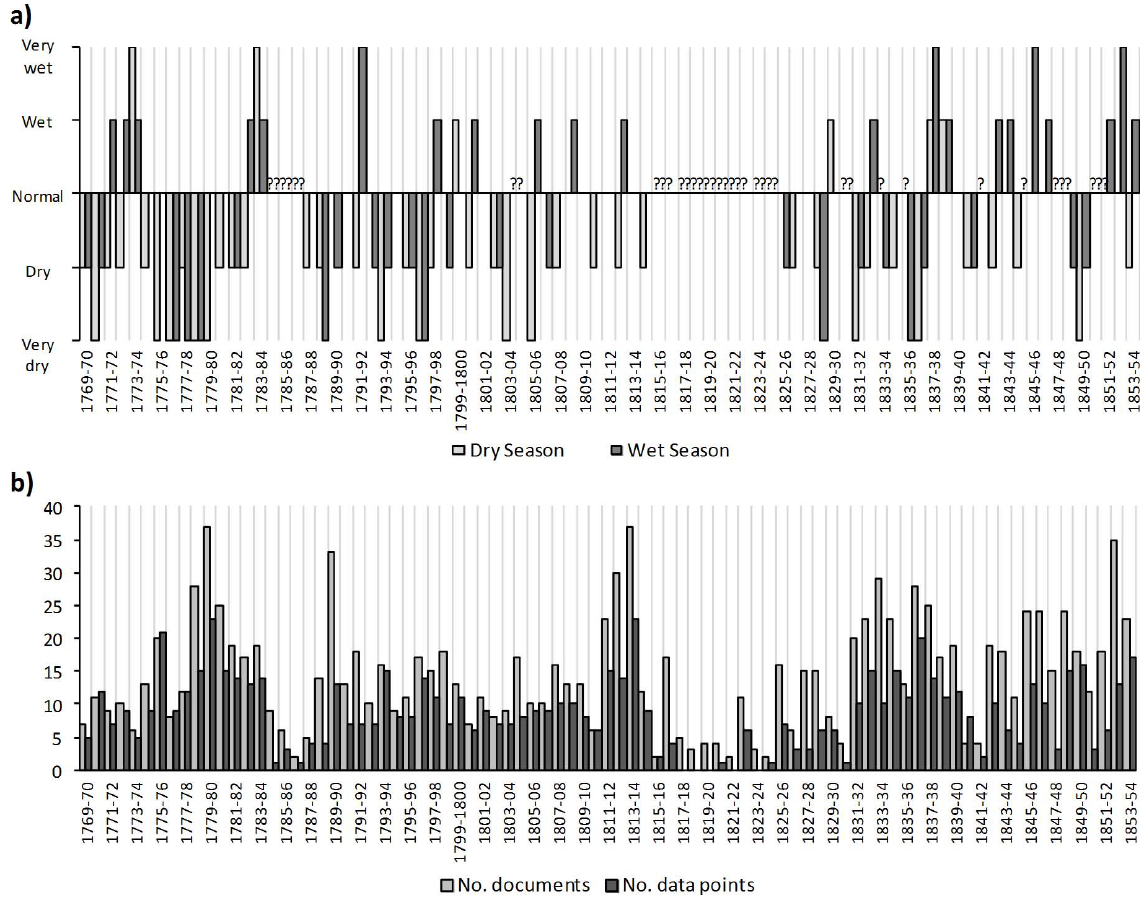
Fig. 5. (a) Document-derived chronology of predominant rainfall conditions experienced at Tudway and Codrington estates in central-eastern Antigua, rain-years 1769–70 to 1853–54. ? denotes unclassified rain-years. (b) Number of documents and data points available for each rain-